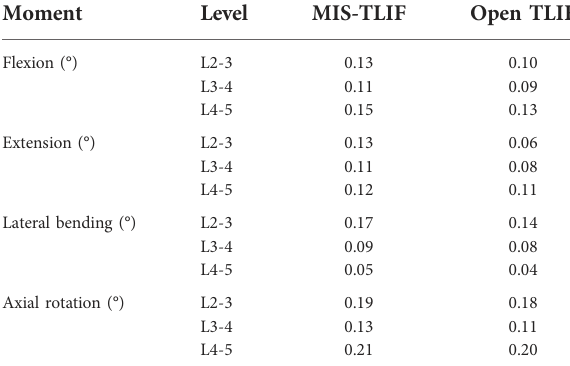
TABLE 6 Range of motion in 3-level